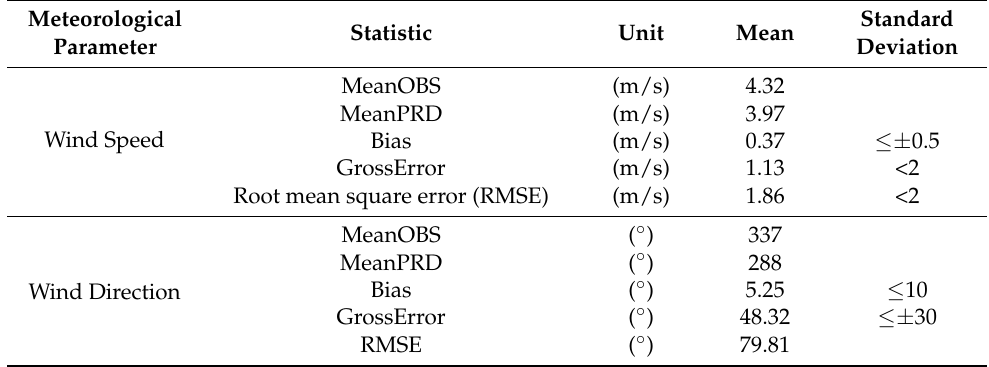
Table 2. Comparison of wind field from WRF simulation and NOAA